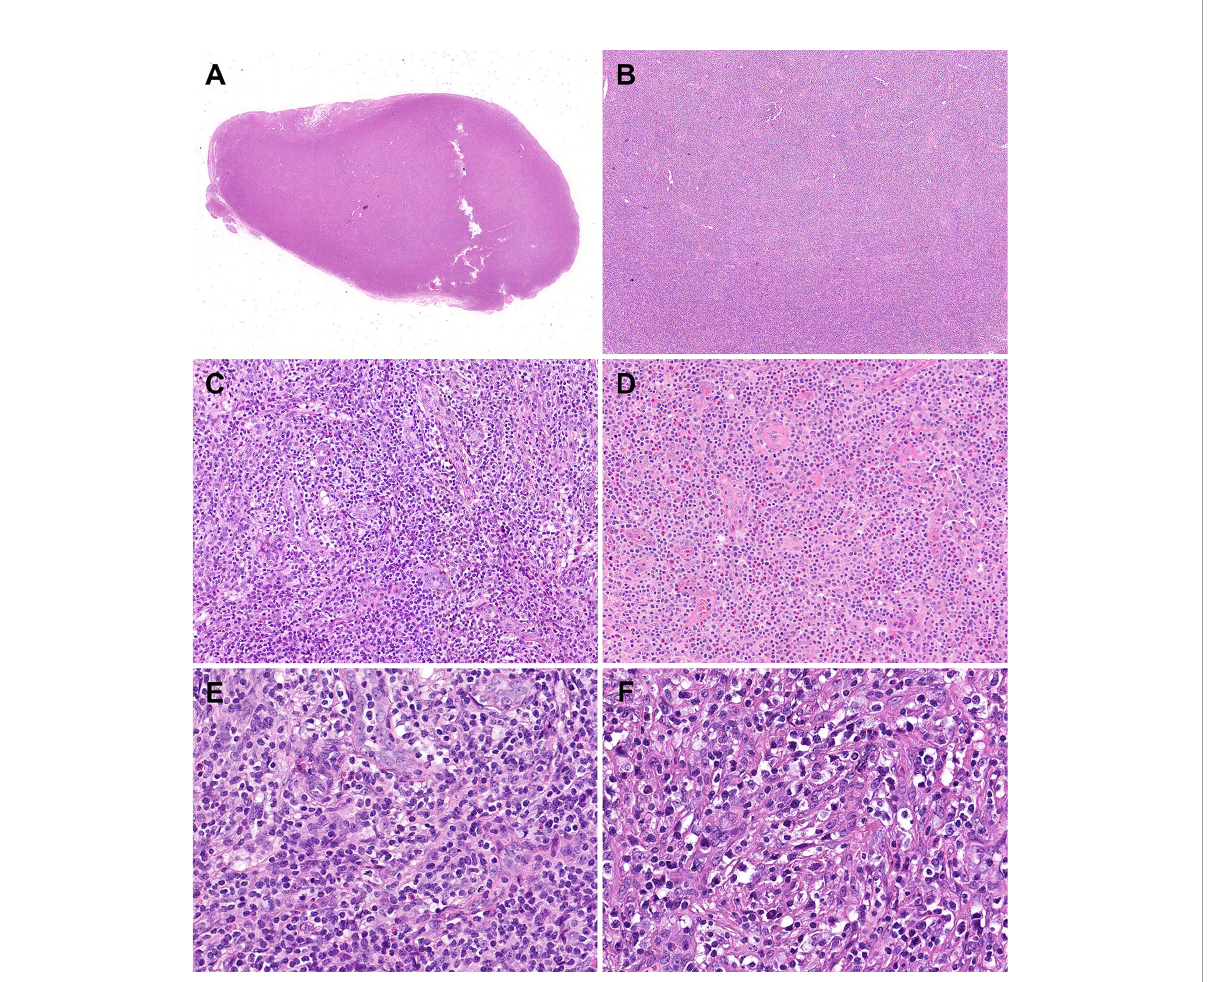
FIGURE 1 Morphological features of CD8-predominant AITL. In the hematoxylin & eosin staining, the CD8-predominant AITL exhibited (A) effaced lymph node architecture (×10), (B) in a diffuse growth pattern (×40), (C) with arborizing HEV proliferation (×200) and (D) eosinophil increase (×200). (E) Medium-sized (×400) or (F) medium-large-sized (×400) neoplastic T-cells with clear to pale cytoplasm surrounding